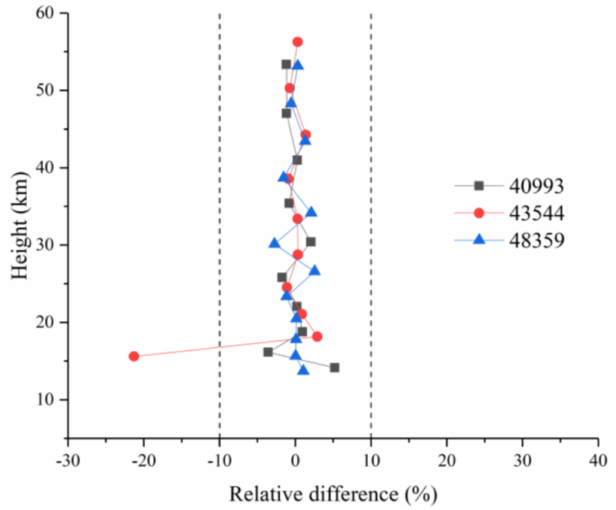
Figure 16. HF relative differences for sr40993, sr43544, and